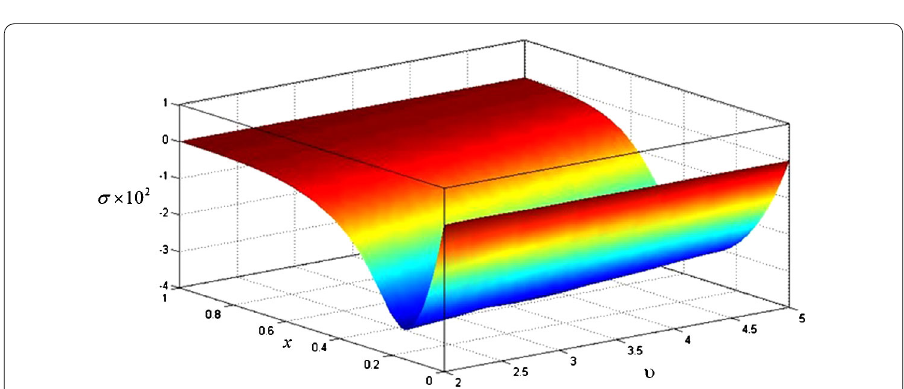
Figure 7 The stress distribution for a wide range of heat source speed when y = z = 0.5